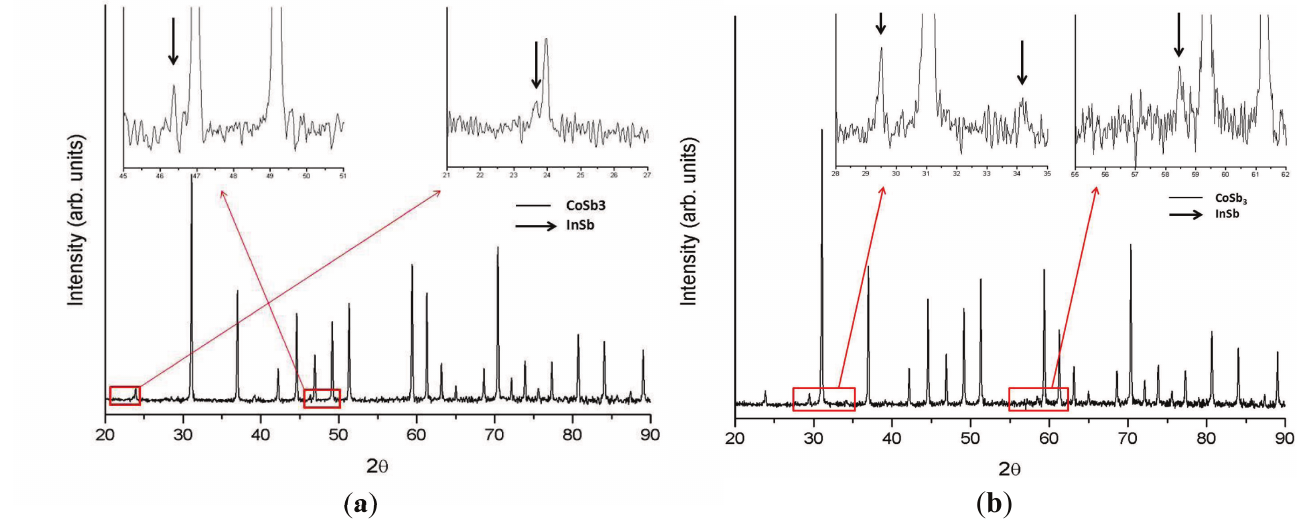
Figure 1. X-ray powder diffraction of the Ce 0.1 In y Yb 0.2 Co 4 Sb 12 skutterudite revealing the presence of minor amounts of ( a ) InSb and ( b ) Yb 2 O 3